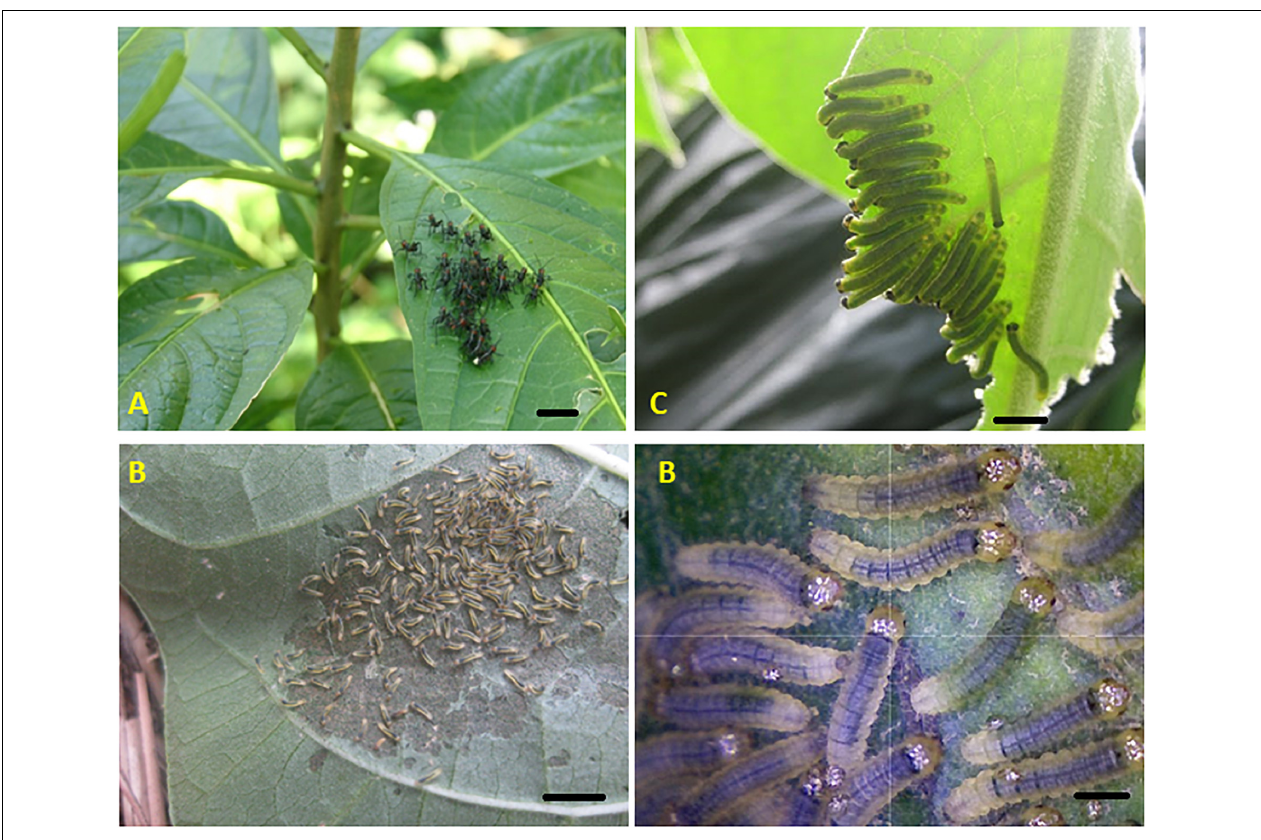
FIGURE 3 | Cooperation in overcoming plant defenses (bottom-up pressures): (A) synchronized feeding by Chromacris psittacus nymphs (Romaleidae), (B) collective leaf windowing by Pagyris cymothoe larvae, and (C) edge feeding by Ithomia larvae (both Ithomiini). All three species observed in secondary vegetation in cloud forest, Ecuador. Black bar in each panel indicates 1